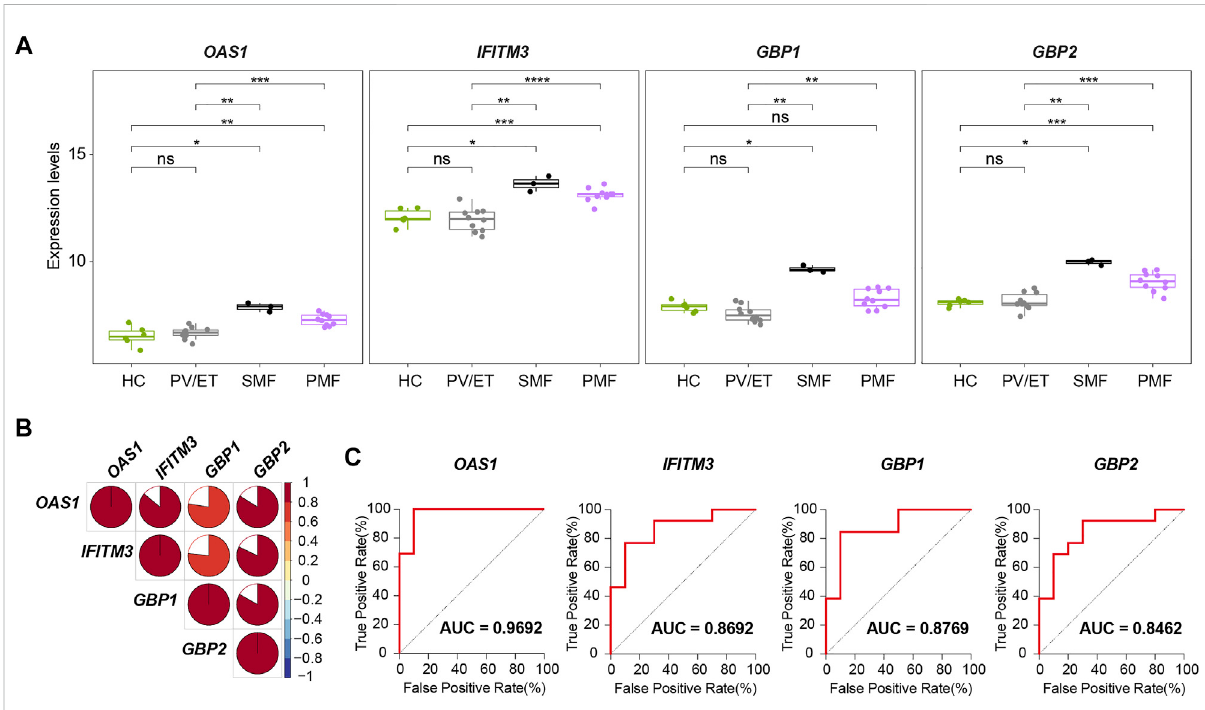
FIGURE 8 (A) ExpressionlevelsoffourkeygenesindistinctMPNsubtypesandHCfromtheexternaldatasets. (B) Correlationoftheexpressionlevelsofthe four key genes in (A) . (C) ROC curves of the four key genes for the diagnosis of JAK2V617F + myelo fi brosis in the external